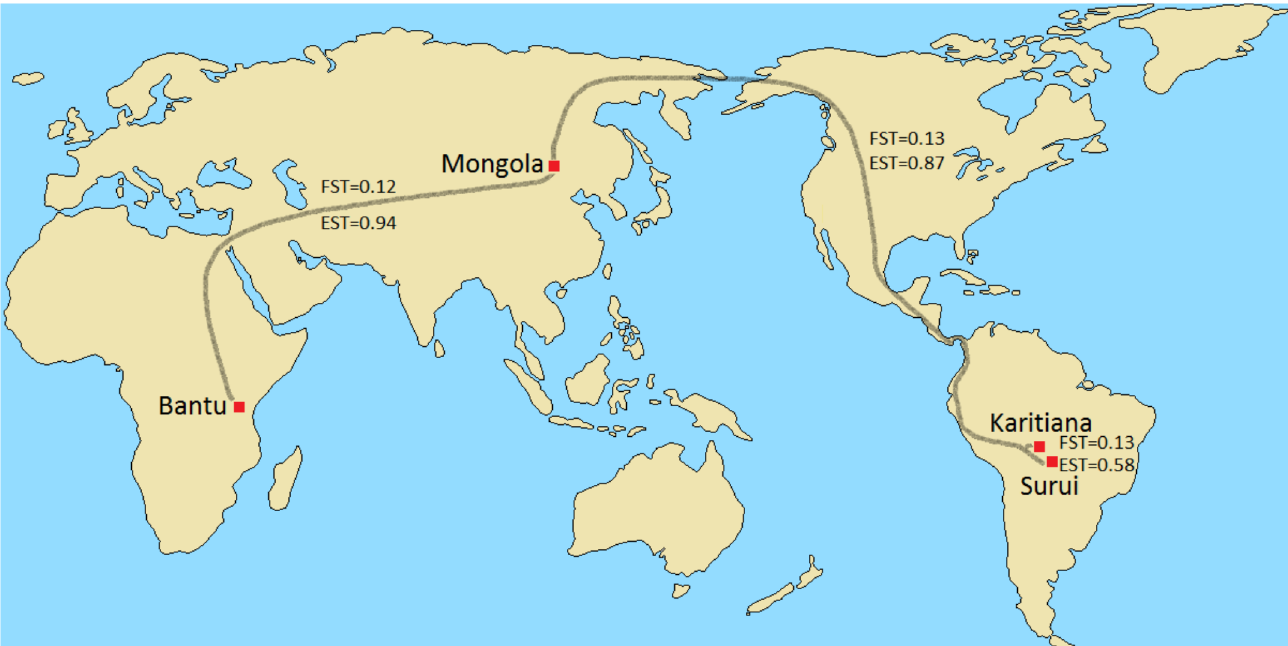
Fig 5. Geographic distance vs. F ST and E ST in various populations. In terms of F ST , the Karitiana are roughly as diverged from the nearby Surui (F ST = 0.13) as they are from the Mongola on the other side of the world (F ST = 0.13) or as the Bantu are from the Mongola (F ST = 0.12). In terms of E ST , differentiation is far greater among these global populations (E ST (cid:1) 0.9) than between the neighboring Amazonian tribes (E ST (cid:1)